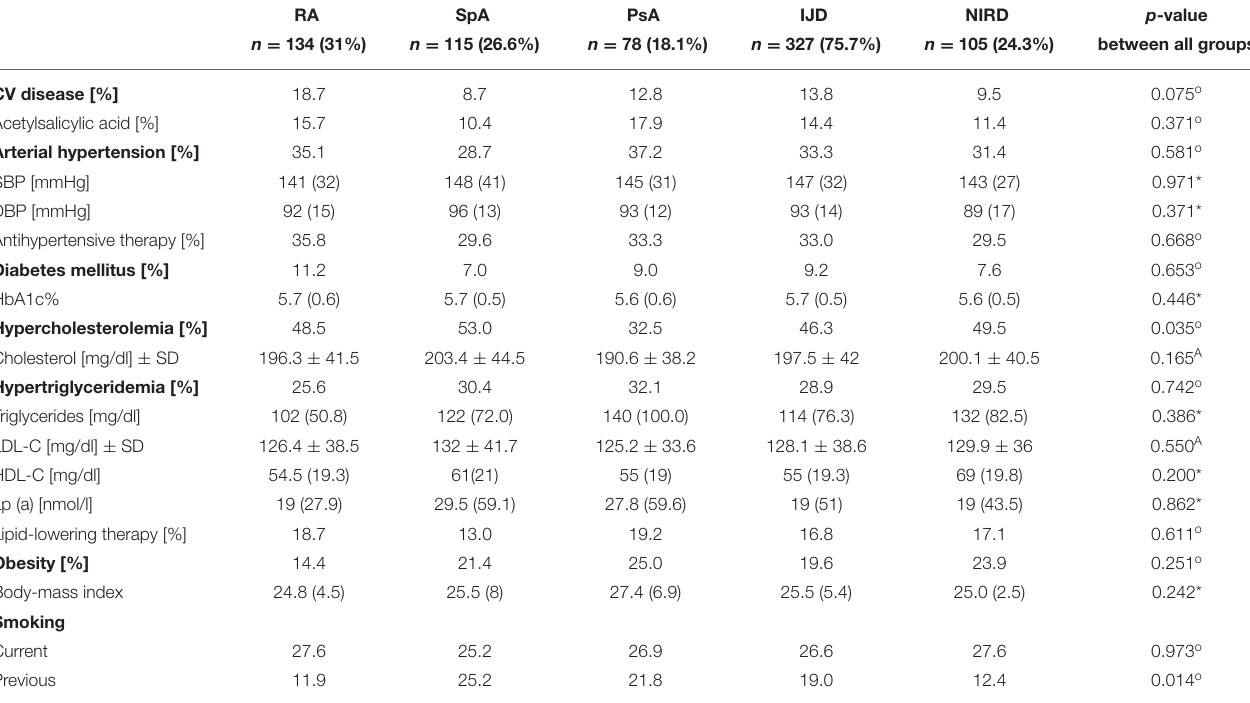
TABLE 4 | Cardiovascular disease, cardiovascular risk factors (in alphabetical order) with laboratory findings and current management of patients with RA, SpA, and PsA, grouped as IJD- and compared to patients with NIRD (data given as medians with interquartile ranges, if not specified otherwise). RA SpA PsA IJD NIRD